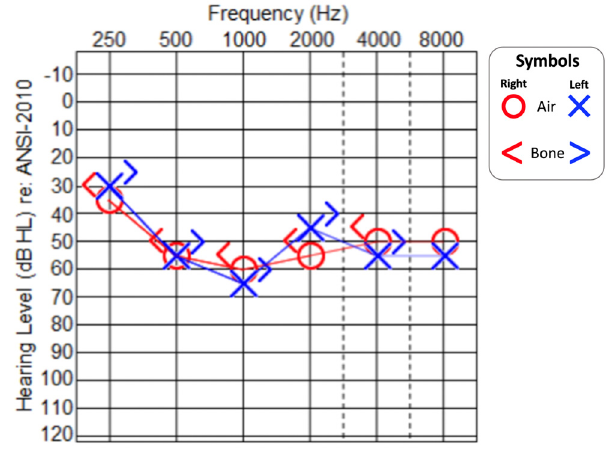
Figure 2. Pure − tone audiogram at 8 years of age during an episode of fever (T = 38.7 °C). Red line: right ear. Blue line: left ear.